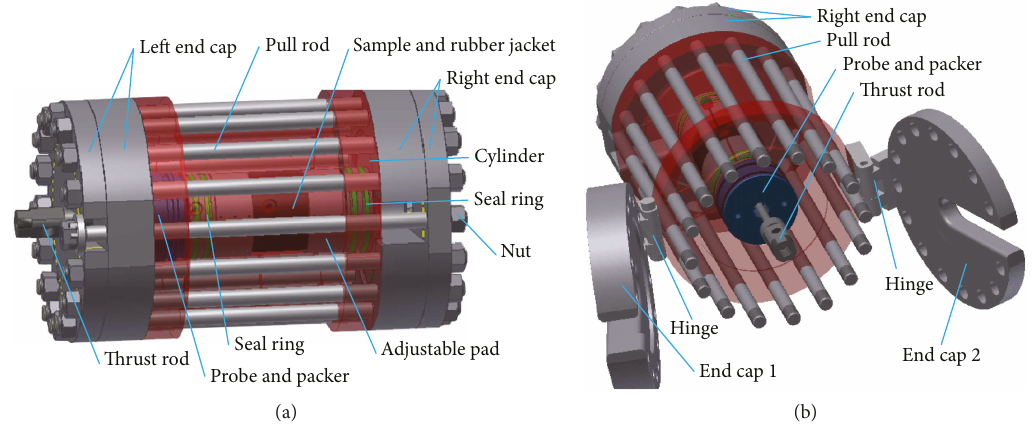
Figure 6: Con fi guration of the core holder. (a) Assembly drawing of the core holder. (b) Opening situation of the left end